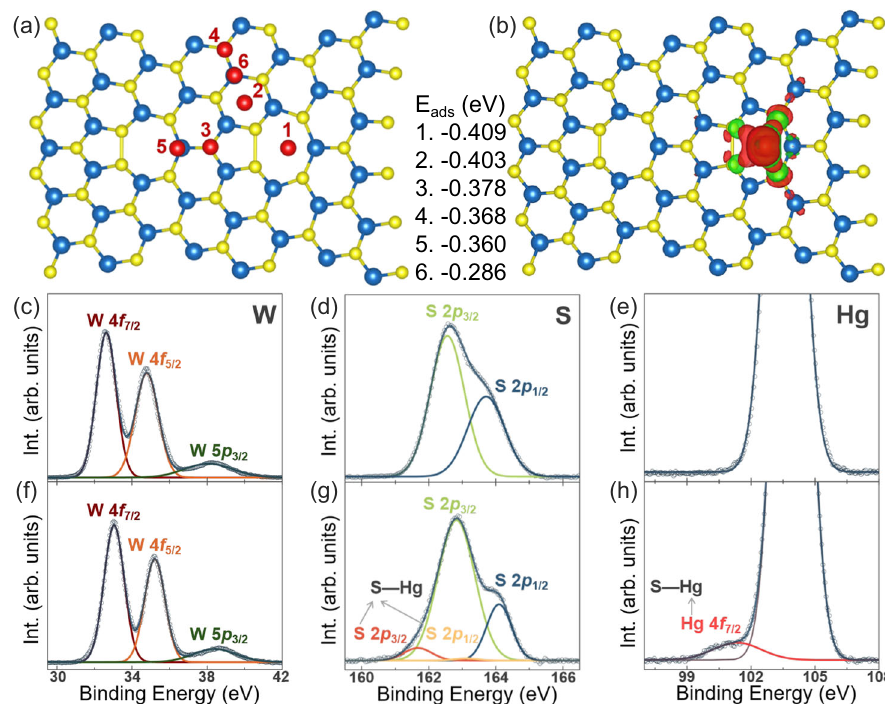
Fig. 3 DFT calculations and XPS characterization. a DFT calculations regarding different adsorption positions of Hg 2 + on grain boundary labeled out with number 1 – 6. b Charge density difference between Hg 2 + and WS 2 with grain boundaries. The calculated adsorption energies of E ads at the 6 different positions are listed between ( a , b ). Yellow, blue, and red spheres represent S, W, and Hg atoms, respectively. There is apparent charge transfer between Hg 2 + and nearby S atoms. The isosurface value is 0.0002 e/Bohr 3 . c – e XPS spectra of W 4 f , S 2 p and Hg 4 f core levels for the as-synthesized 1L WS 2 fi lm. f – h And corresponding XPS spectra of the 1L WS 2 fi lm after Hg 2 + detection. Notably, the XPS peak at 104.54 eV in ( e , h ) is ascribed to Si from wafer.